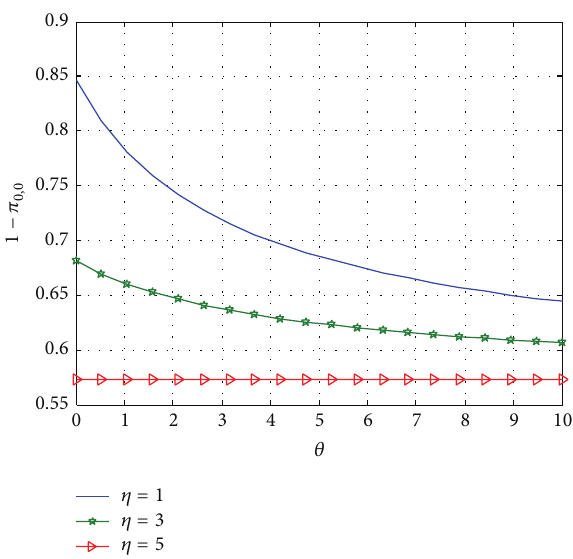
Figure 3: The effect of 𝜃 on 1 − 𝜋 0,0 for different values of 𝜂